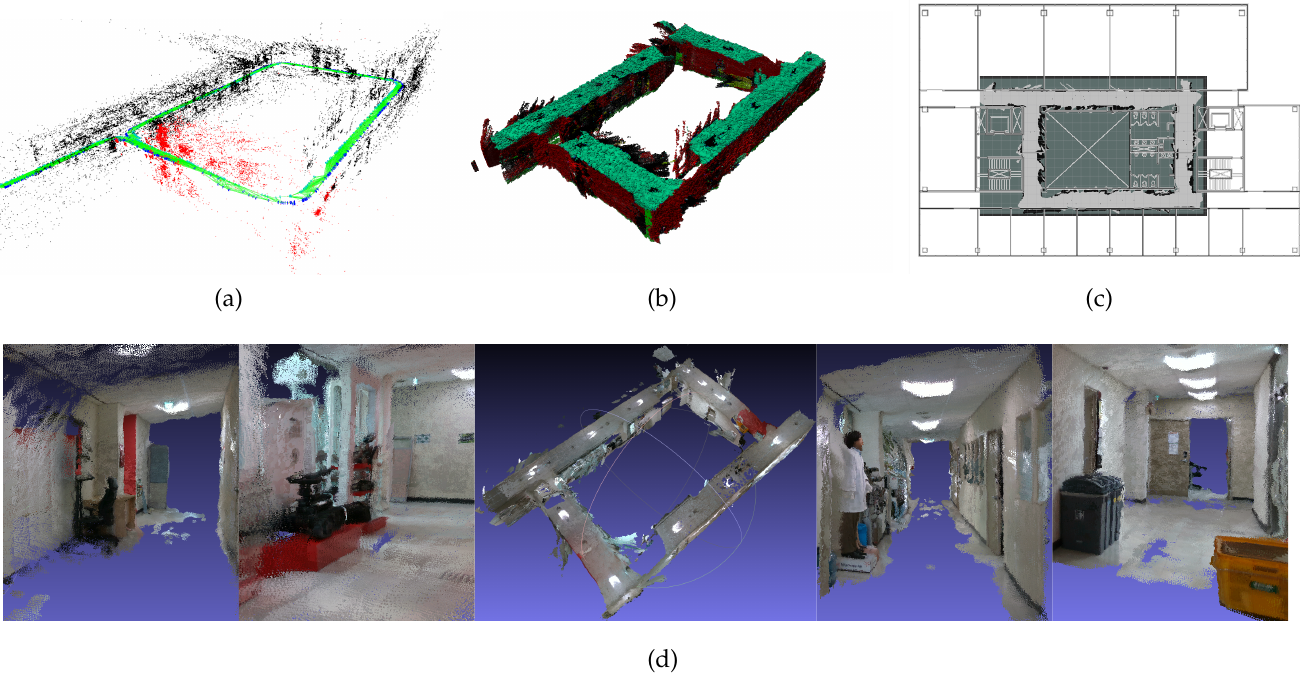
Figure 9. Different forms of the output of the KIST-03 sequence using RGB-D sensors. ( a ) sparse map of the environment, ( b ) 3D octomap of the map, ( c ) 2d occupancy gridmap aligned with the floor plan, ( d ) RGB pointcloud of the